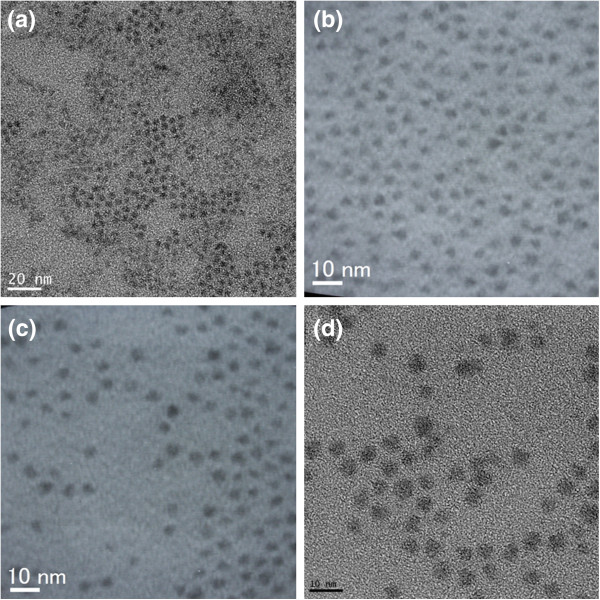
TEM images of CdTe0.5Se0.5cores and CdTe0.5Se0.5/Cd0.5Zn0.5S core/shell QDs shown in Table3. (a) Sample 5 (CdTe0.5Se0.5), (b) samples 5–4 (CdTe0.5Se0.5/Cd0.5Zn0.5S), (c) sample 5–8 (CdTe0.5Se0.5/Cd0.5Zn0.5S), and (d) sample 5–9 (CdTe0.5Se0.5/Cd0.5Zn0.5S). Samples 5–4, 5–8, and 5–9 were prepared by using sample 5.